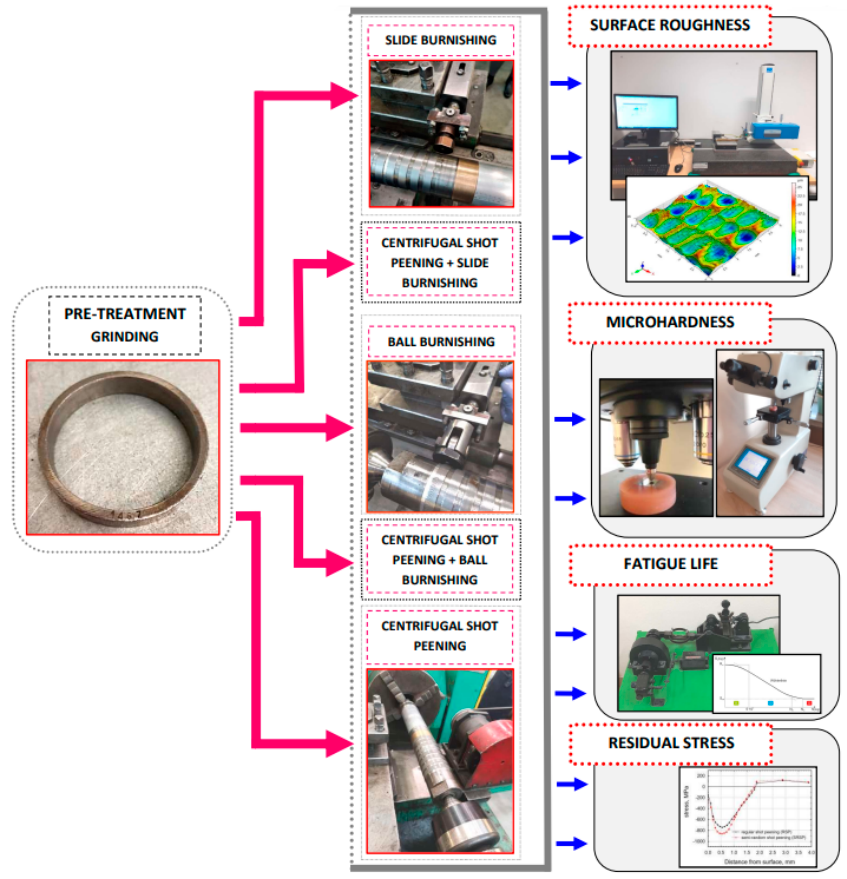
Figure 3. Research Figure 3. Research methods.